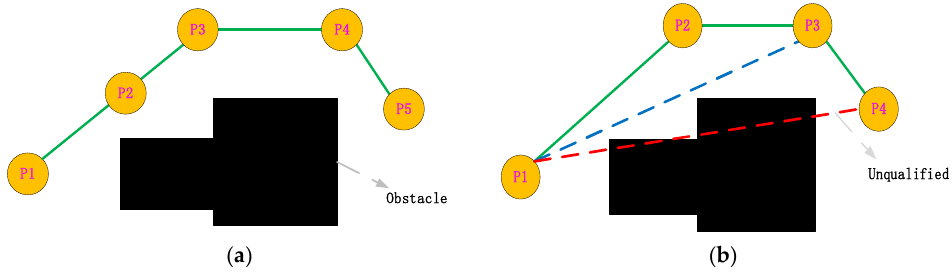
Figure 3. Redundancy point deletion strategy. ( a ) Step 1. ( b ) Step 2.